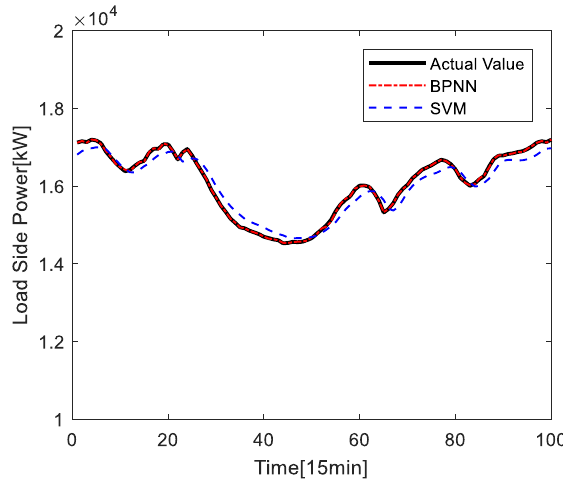
Figure 16. Prediction results of load power in the No. 1 power system.